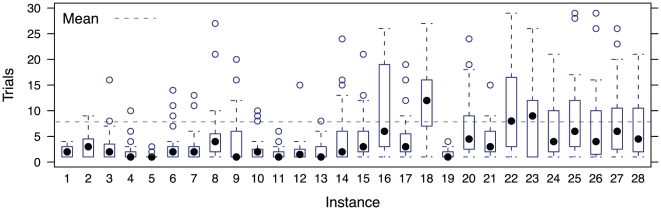
Trials per instance.